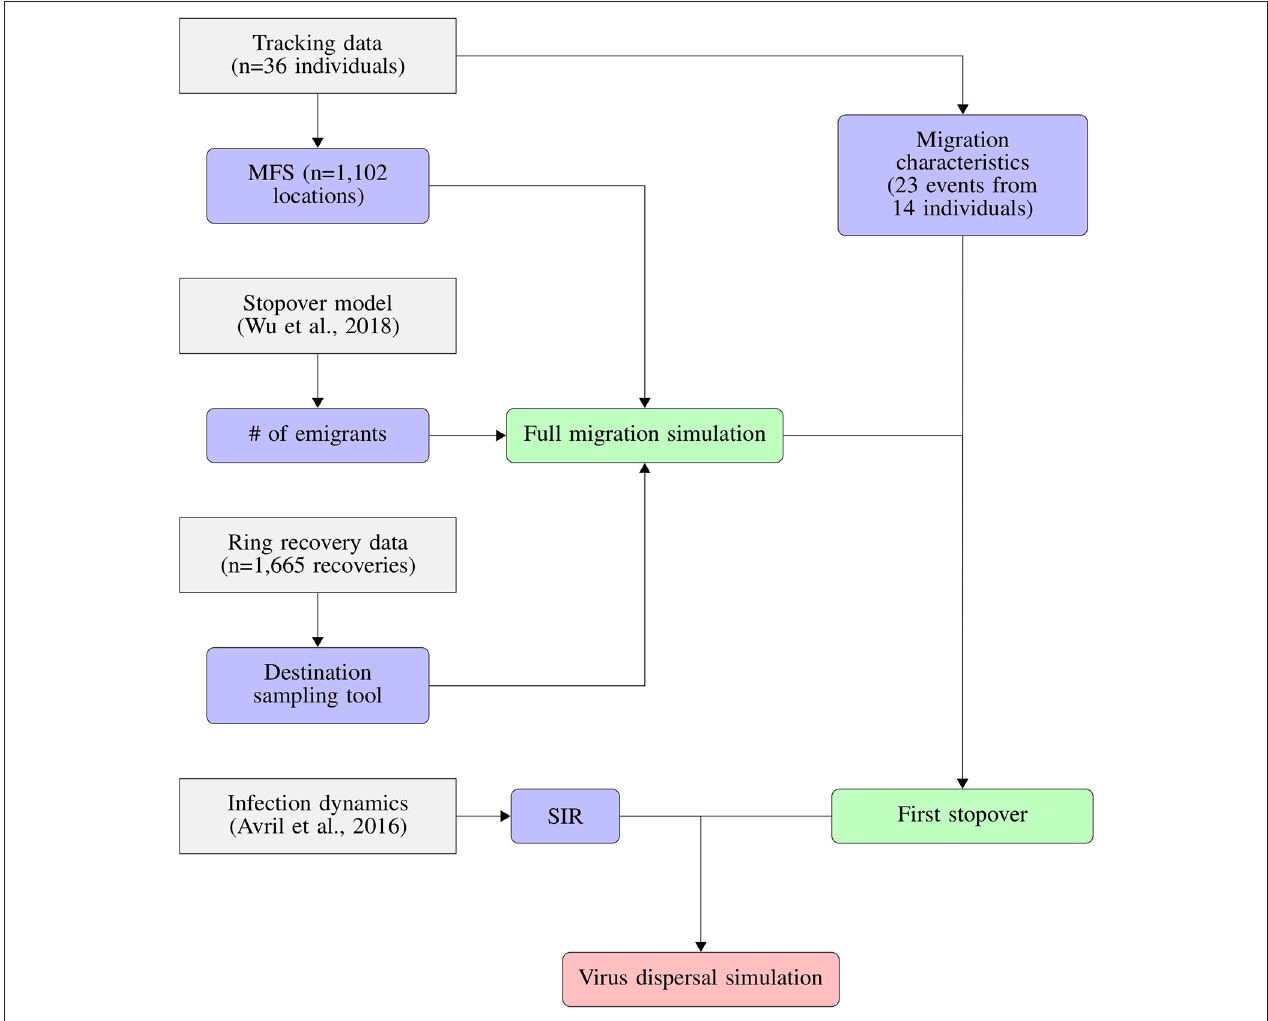
FIGURE 1 | Conceptual flowchart showing how we combined tracking data, stopover model, ring recovery data and infection dynamics to predict the dispersal of LPAIV by migrating mallards. Tracking data were used to derive both migration characteristics like migration duration and distance, as well as the Mallard Flight Simulator ( MFS ). The implementation of the susceptible-infection-recovery model (SIR) is detailed in Figure 2